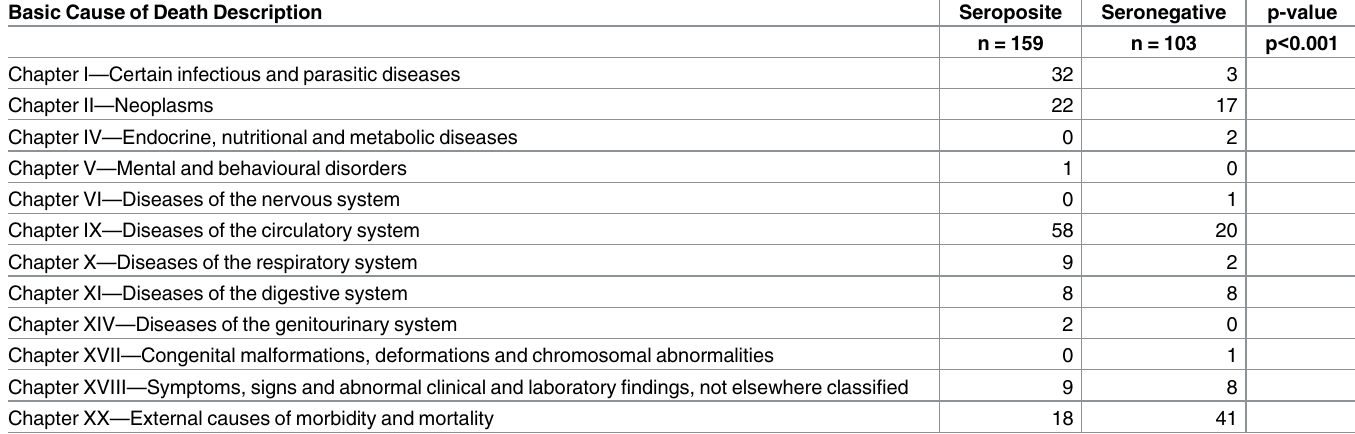
Table 2. Comparison of deceased blood donors seronegative and seropositive for Chagas disease, at FPS, S ã o Paulo, Brazil, from 1996–2000, by ICD-10 chapters of the underlying causesof